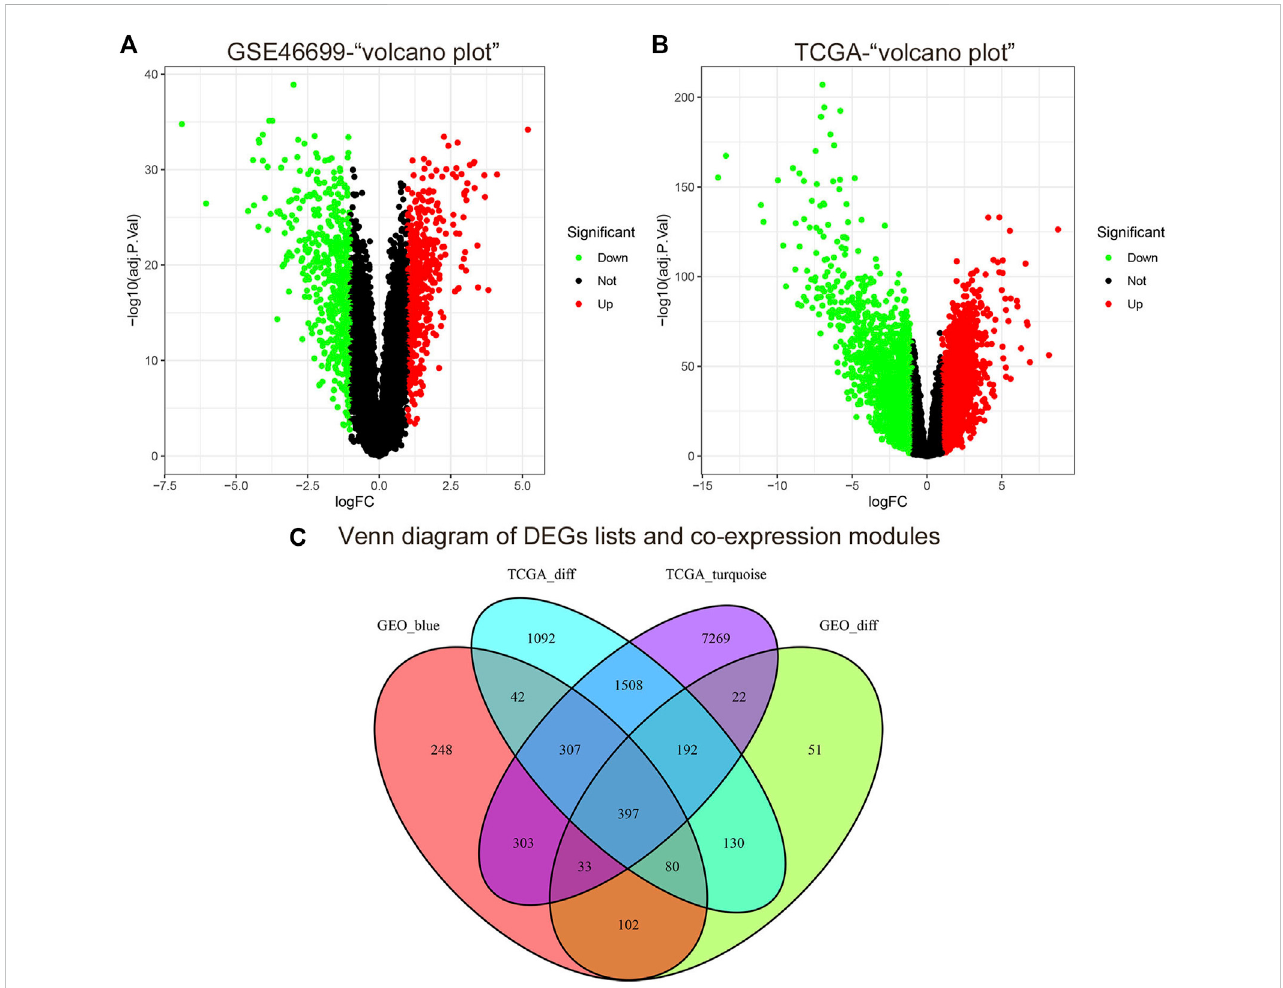
FIGURE 4 The cut-off criteria for screening differentially expressed genes in GSE46699 and TCGA datasets of ccRCC were | log FC | > 1.0 and adj. p < 0.05. (A) Volcano map of differentially expressed genes in the GSE46699 data set. (B) Volcano map of differentially expressed genes in the TCGA dataset. (C) Venn diagram of gene crossover between differentially expressed genes and co-expression module. In total, 397 overlapping genes in the intersection of differentially expressed genes and two co-expression